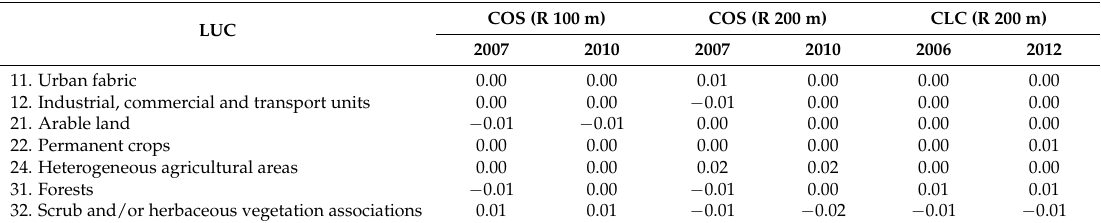
Table 5. Main variation areas (gain ≥ 0.01% and loss ≤− 0.01% of mainland Portugal) of the LUC raster (COS 2007 and 2010; CLC 2006 and 2012) relative to LUC areas in vector GI. COS (R 100 LUC